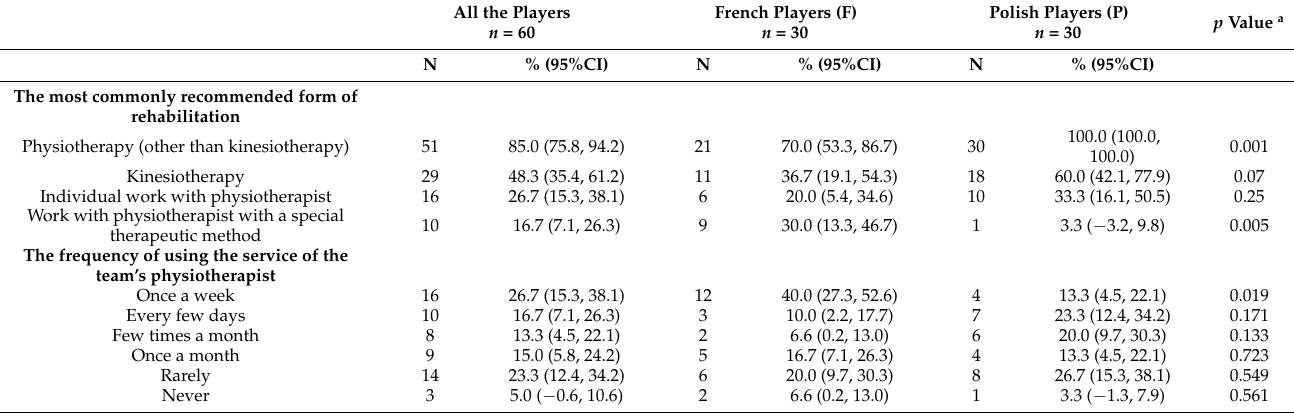
Table 6. The most common rehabilitation procedures performed after injury occurrence reported by rugby players ( n = 60).